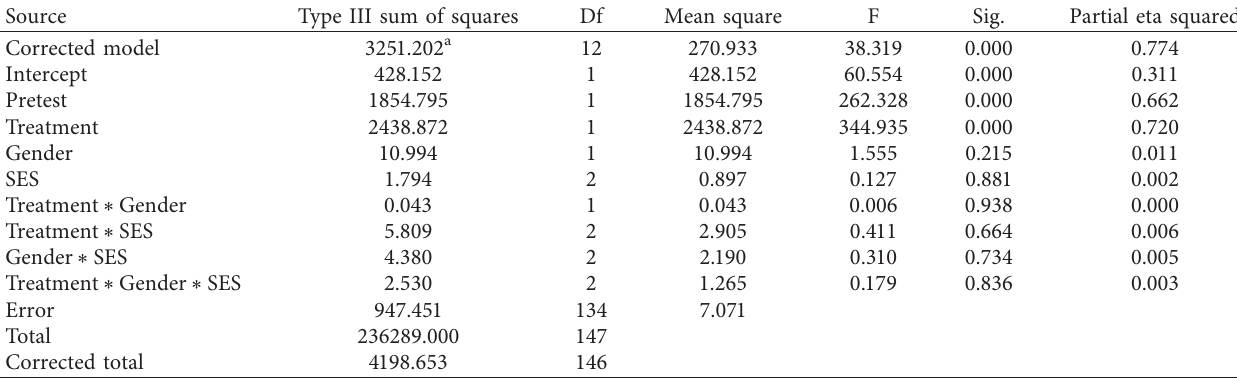
Table 2: ANCOVA of postattitude rating of students by treatments, gender, and SES. Source Type III sum of squares